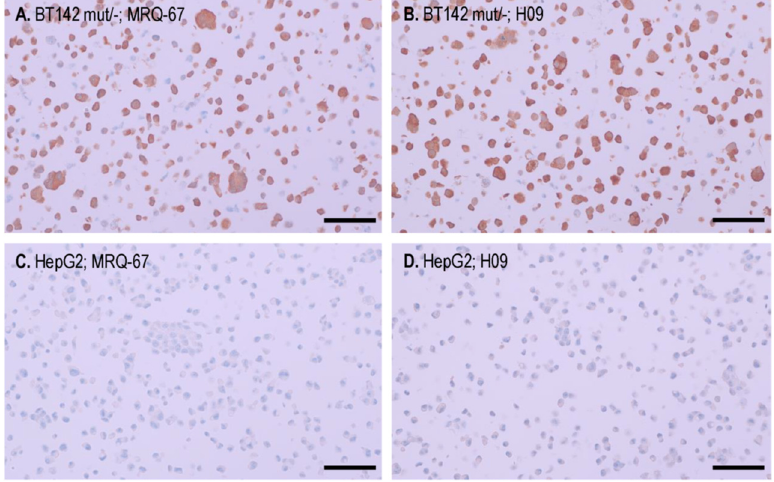
Figure 3. Binding of the antibodies MRQ-67 ( A , C ) and H09 ( B , D ) with endogenous IDH1 R132H mutant, but not with the IDH1 wt protein, as demonstrated on cell pellet samples of cell lines BT142 mut/- ( A , B ) and HepG2 ( C , D ) by IHC. UltraView, visualized with DAB, and counterstained with hematoxylin. Scale bar = 100 µm.